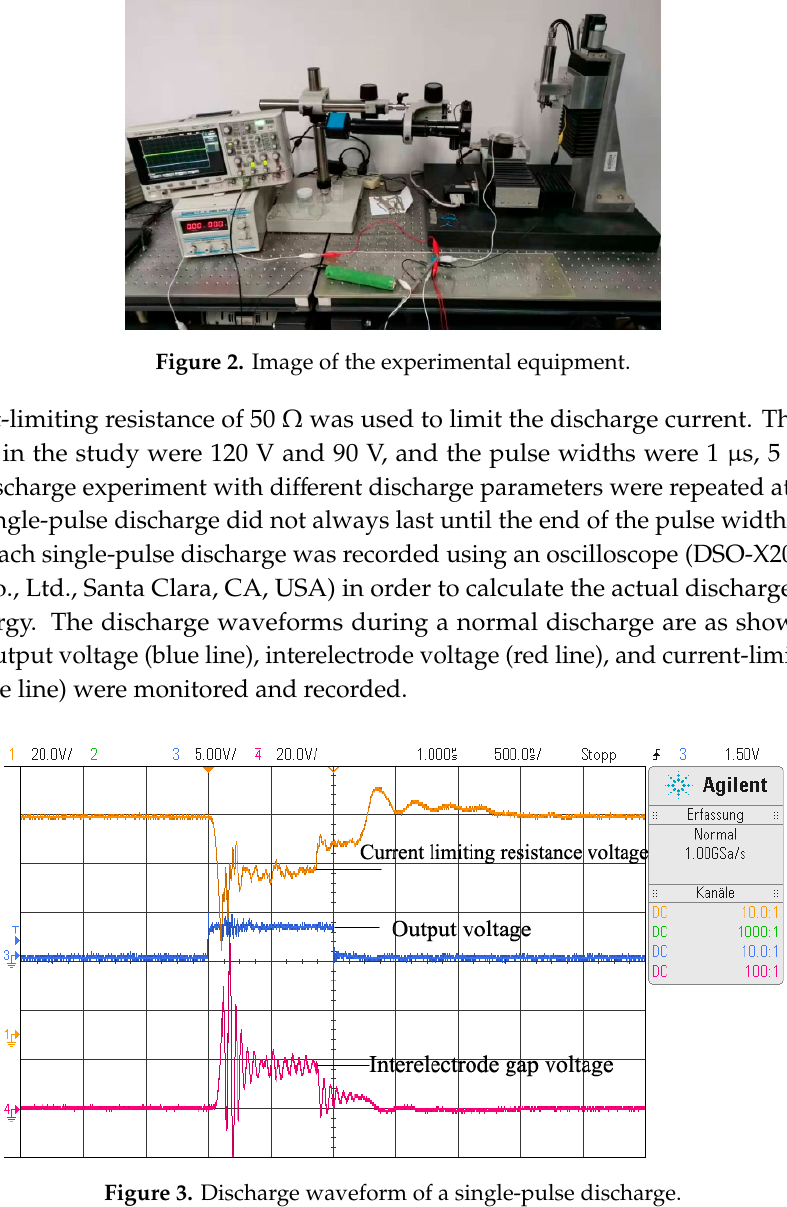
Figure 3. Discharge waveform of a single-pulse discharge.